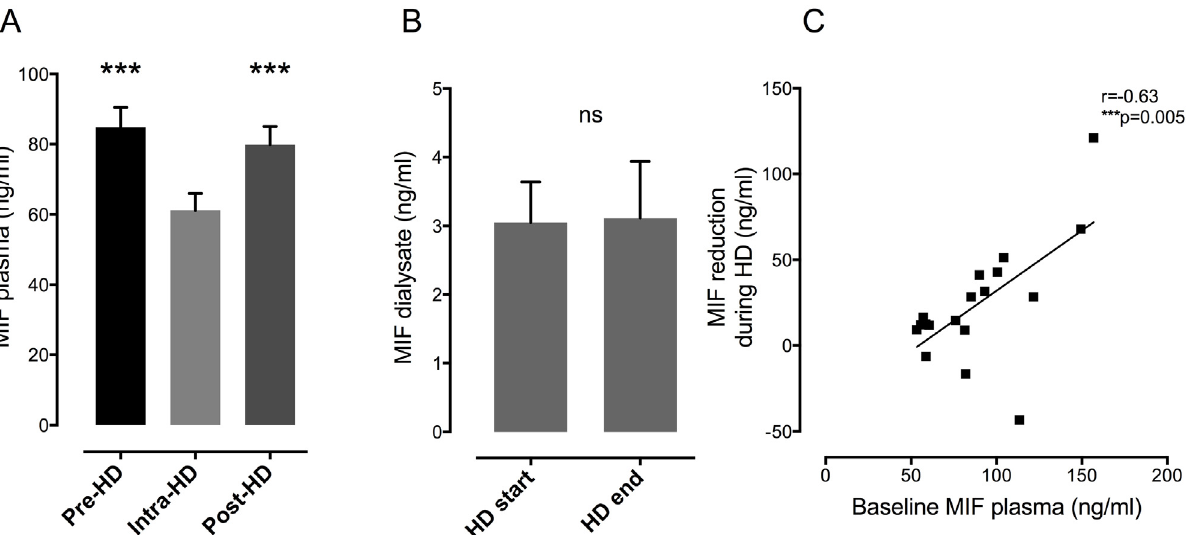
Fig 2. MIF plasma level decrease during HD and restore after termination of renal replacement therapy. A ) MIF plasma level decrease during HD (Intra-HD) compared to baseline levels (Pre-HD) (p < 0.01). After termination of HD (Post-HD), MIF plasma level return to baseline values (Pre-HD vs. Post- HD; p = ns). B ) MIF can be measured in the ultrafiltrate (UF) immediately after beginning of HD (HD start). Concentration of MIF in UF does not change over time as demonstrated by measurements at the end of HD session (HD end)(p = ns). C ) The absolute amount of removed MIF is associated with the baseline amounts of MIF plasma levels in ESRD patients (p <